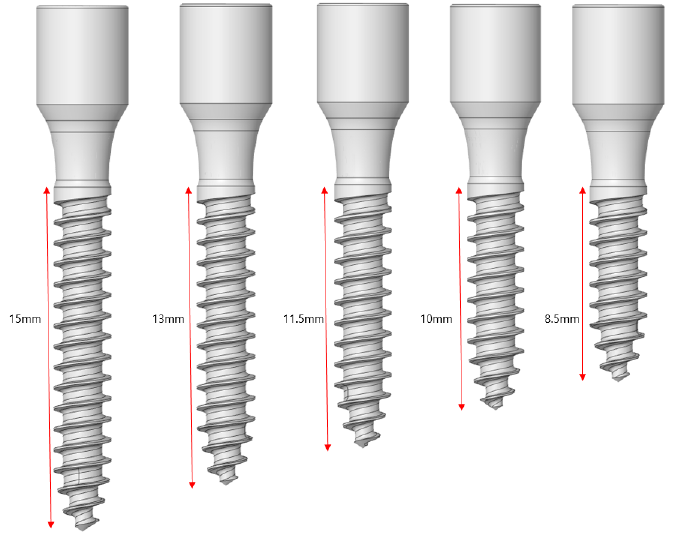
Figure 4. Implant length change.